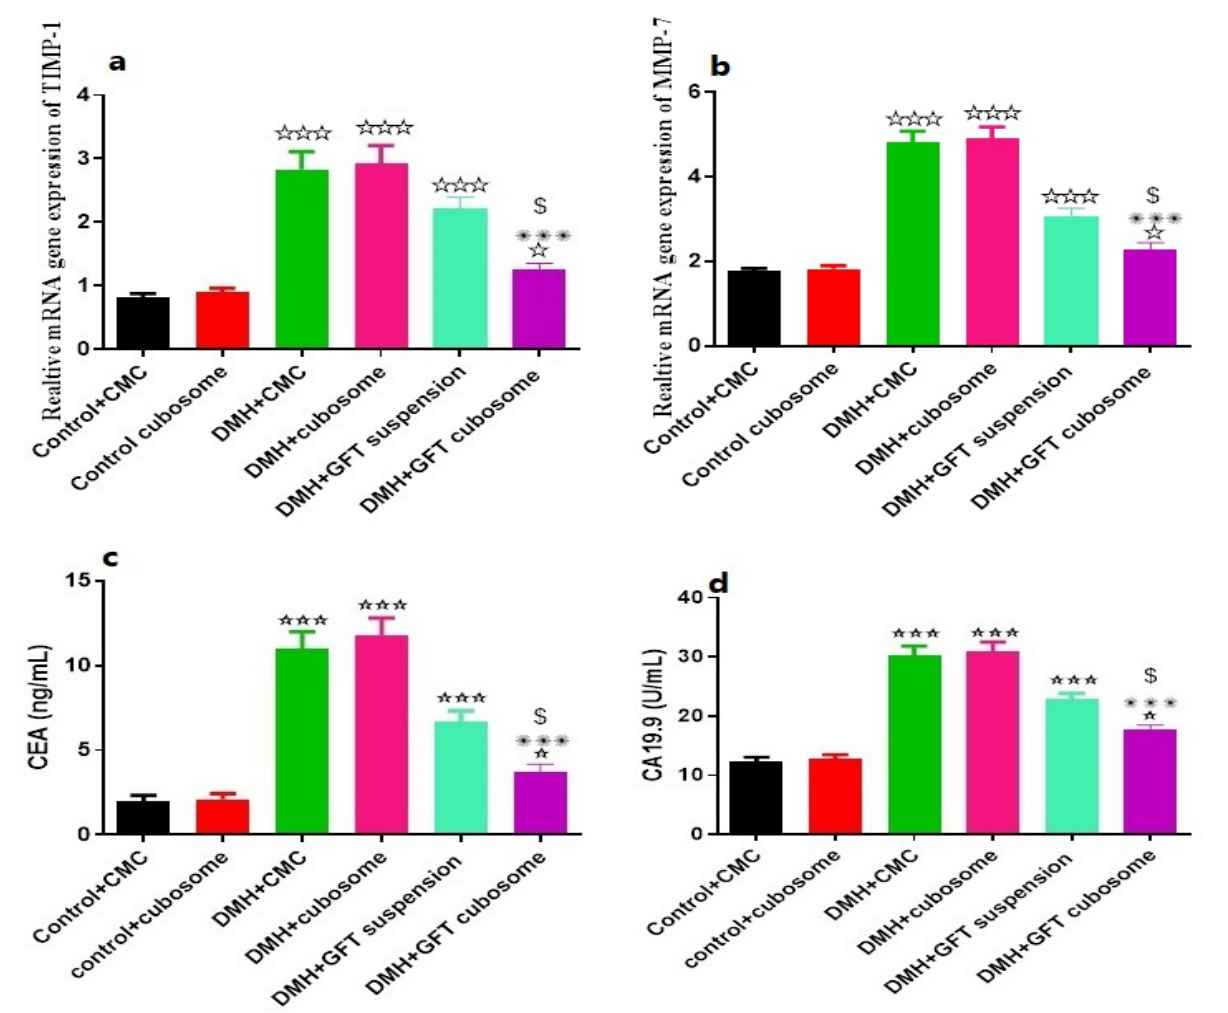
Figure 13. Effects of GFT and/or GFT‑CNPs on gene expression levels of ( a ) TIMP‑1 and ( b ) MMP‑ Figure 13. Effects of GFT and/or GFT-CNPs on gene expression levels of (a)TIMP-1 and (b) MMP-7, Figure 13. Effects of GFT and/or GFT-CNPs on gene expression levels of (a)TIMP-1 and (b) MMP-7, 7, and serum levels of ( c ) CEA and ( d ) CA19‑9. Data are presented as mean ± SEM ( n = 12). ☆ , and serum levels of (c) CEA and (d) CA19-9. Data are presented as mean ± SEM (n = 12 ). ☆ , ✺ and and serum levels of (c) CEA and (d) CA19-9. Data are presented as mean ± SEM (n = 12 ). ☆ , ✺ and Figure 13. Effects of GFT and/or GFT-CNPs on gene expression levels of (a)TIMP-1 and (b) MMP-7, Figure 13. Effects of GFT and/or GFT-CNPs on gene expression levels of (a)TIMP-1 and (b) MMP-7, Figure 13. Effects of GFT and/or GFT-CNPs on gene expression levels of (a)TIMP-1 and (b) MMP-7, and $ indicate significant change from Control group, DMH group and DMH + GFT suspension $ indicate significant change from Control group, DMH group and DMH + GFT suspension $ indicate significant change from Control group, DMH group and DMH + GFT suspension and serum levels of (c) CEA and (d) CA19-9. Data are presented as mean ± SEM (n = 12 ). ☆ , ✺ and and serum levels of (c) CEA and (d) CA19-9. Data are presented as mean ± SEM (n = 12 ). ☆ , ✺ and and serum levels of (c) CEA and (d) CA19-9. Data are presented as mean ± SEM (n = 12 ). ☆ , ✺ and respectively. ☆ and $, indicate significant change at p < 0.05; ☆☆☆ and